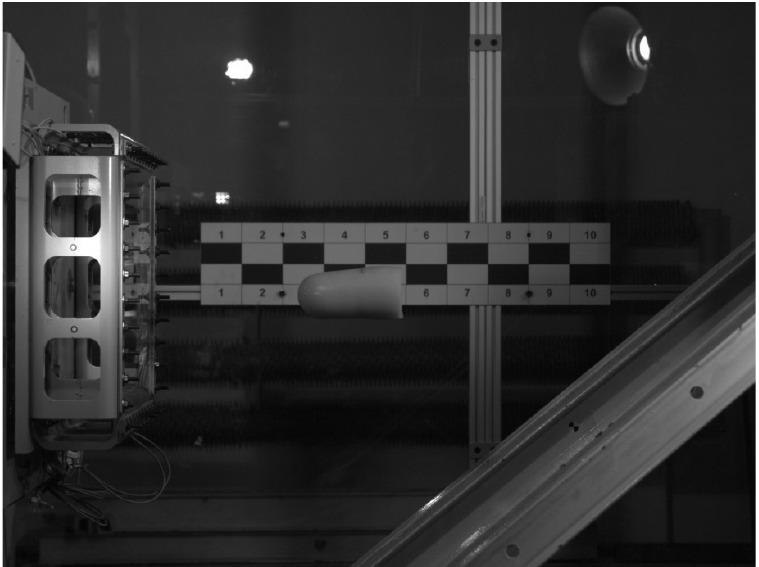
Figure 9. Snap-shot from the high-speed camera measuring of a projectile velocities. For each shot, the values of forces measured by 4 load sensors (F1, F2, F3, F4) and the values of strains measured by strain gauges (SG1, SG2, SG3) were recorded. In addition, the speed of the projectile, the view of individual sequences of the projectile’s strains and the diameter of the deformed projectile were recorded with a set of cameras, on the basis of a grid of circles placed on the rigid plate. The diameter was measured for each subsequent frame of the film recorded by the cameras. The registration of the above data allowed the developing of graphs of the total force, strain values and pressure. In order to achieve a temporary synchronization of the indications of the force sensors with the measurement of the projectile diameter, the analysis was started when the sum of the measured forces increased significantly above the zero value. Based on the data presented in Figure 10, the equation of the relationship of the mid-diameter change (linear) was determined.